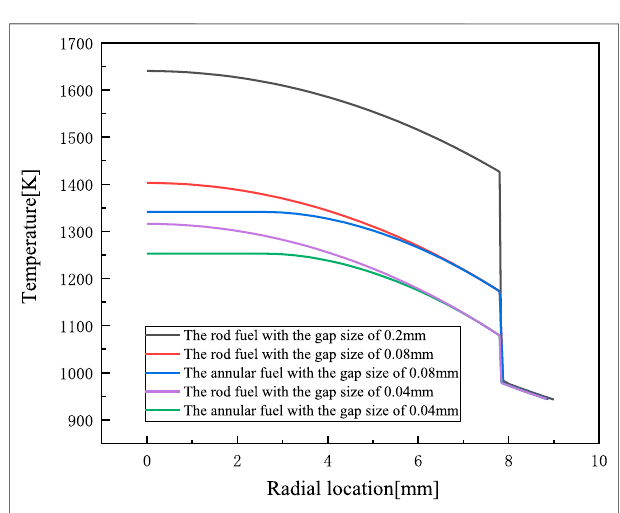
FIGURE 1 | Steady-state operating temperature of fi ve different designs of fuel in 45 kW/m.